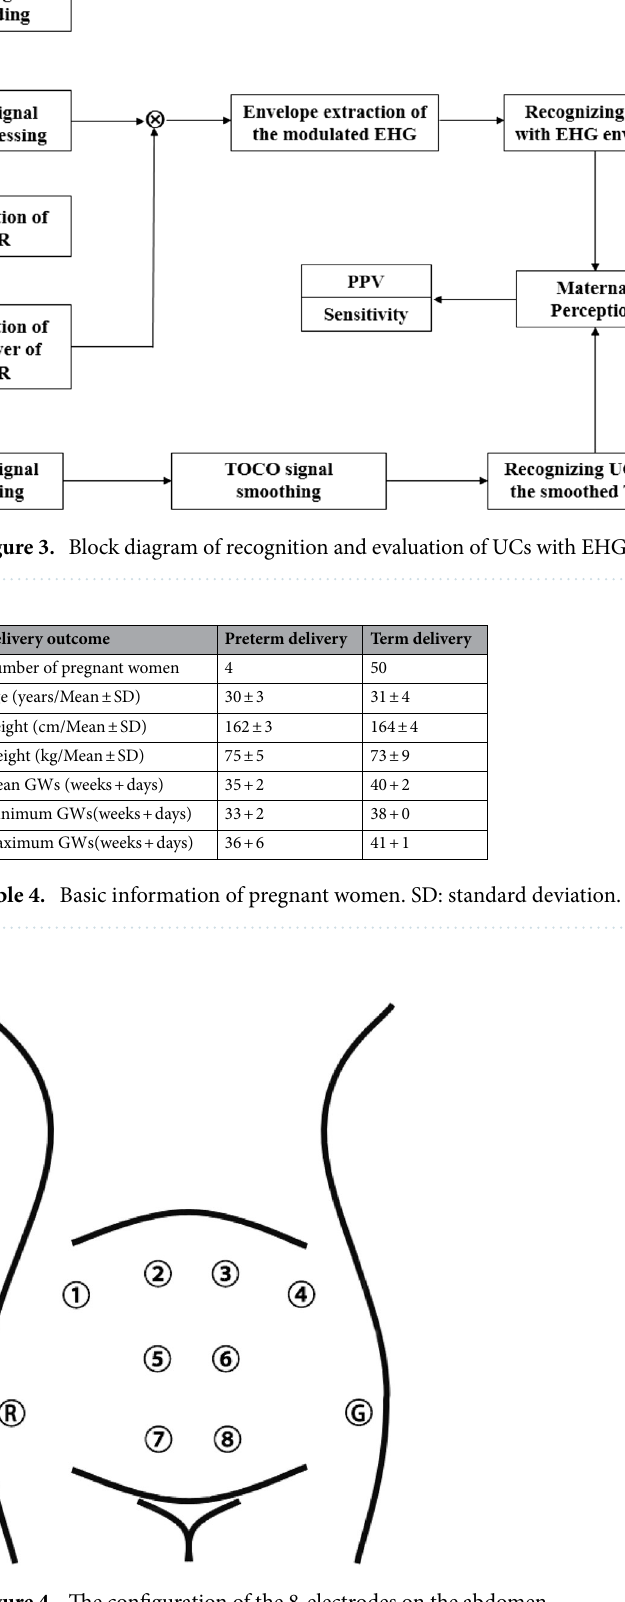
Figure 4. The configuration of the 8-electrodes on the